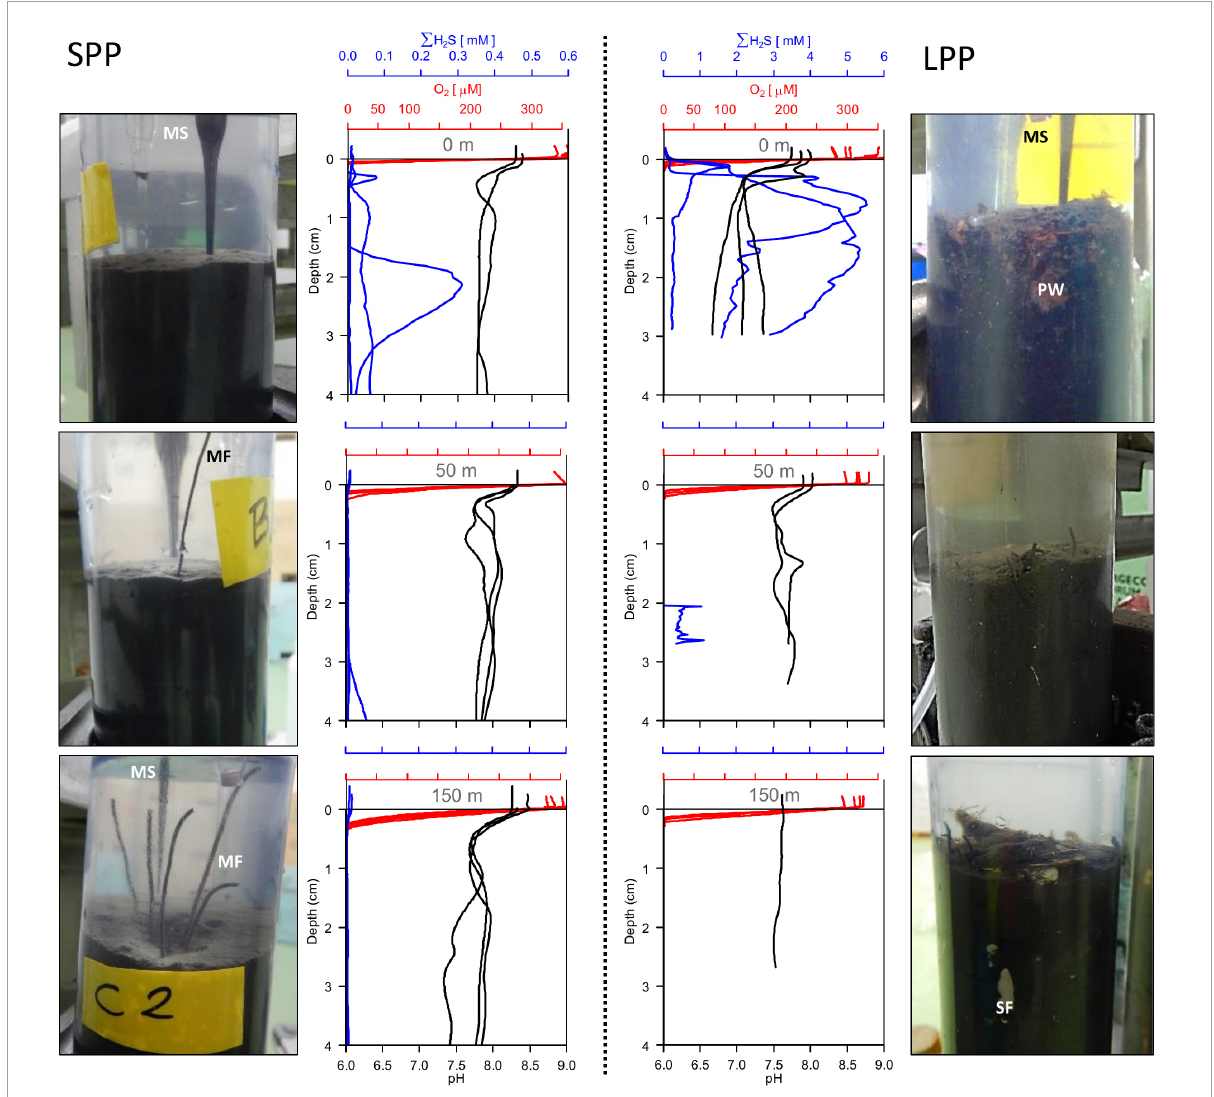
FIGURE1 Sediment pictures and microsensor sediment profiles retrieved from two fish farming sites (short and long production period) at 0 m (top row) , 50 m (middle row) , and 150 m (bottom row) away from the cage along the transect. SPP, short production period (Left); LPP, long production period (Right). All replicate profiles are plotted for each station; red, oxygen; blue, total sulfide; black, pH. Photos of sediment cores (diameter: 6 cm) indicate microsensor entering the sediment (MS), particle waste (PW), macrofauna (MF), and shell fragments